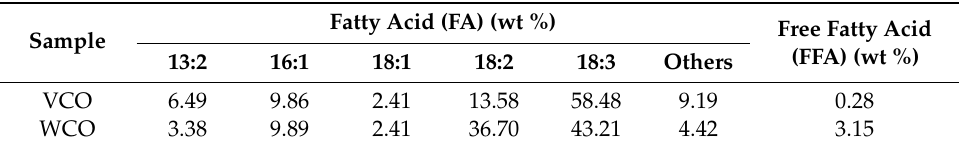
Table 3. Fatty acid compositions of virgin cooking oil (VCO) and waste cooking oil (WCO) used in this study.